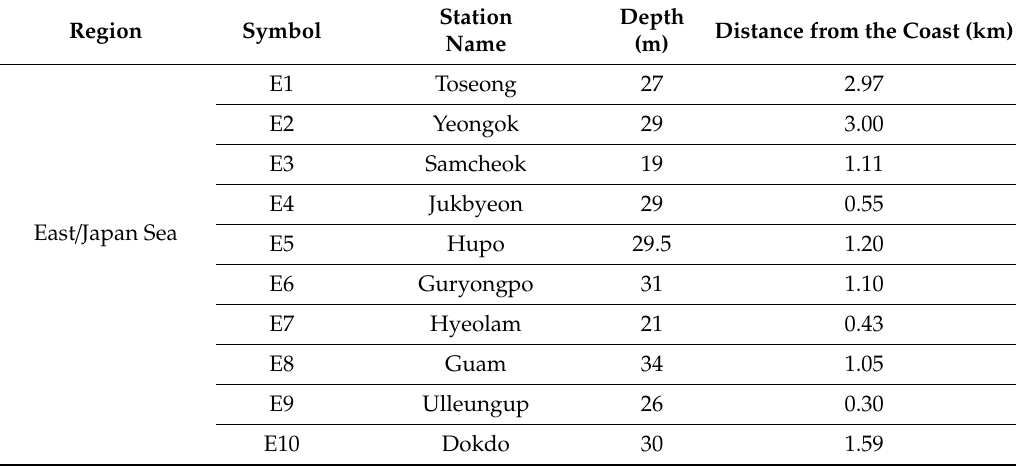
Table 2. Information on coastal wave buoys of the Korean Meteorological